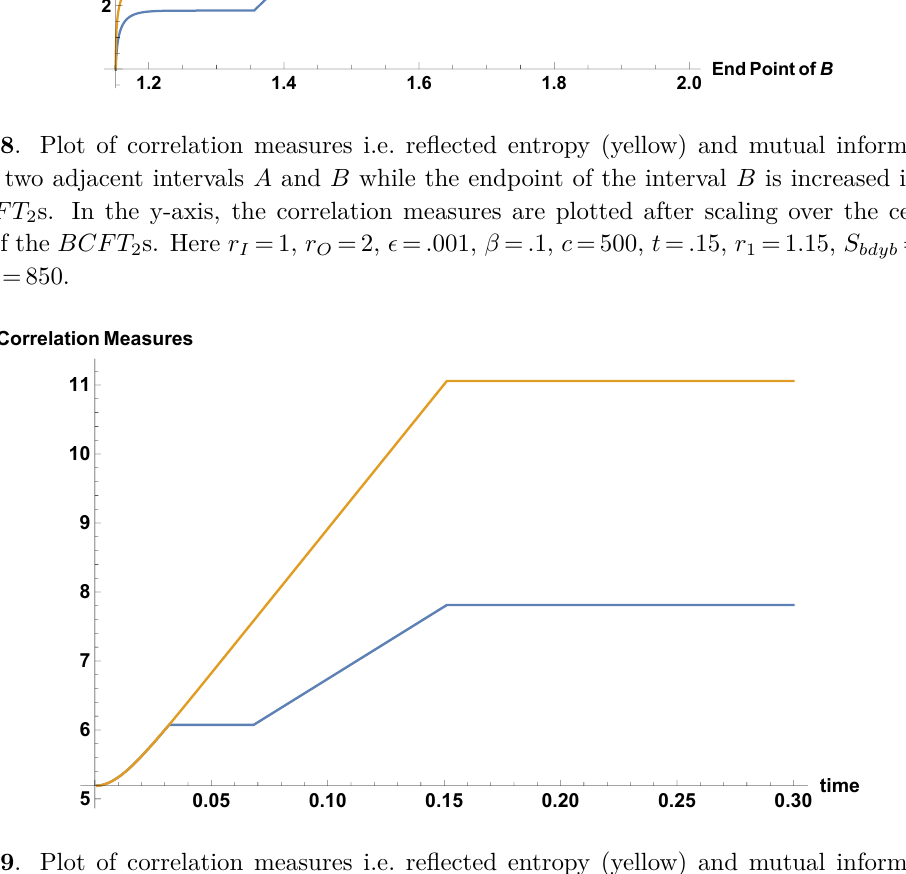
Figure 39 . Plot of correlation measures i.e. reflected entropy (yellow) and mutual information (blue) for two adjacent intervals A and B in the dual BCFT 2 s with increasing time. In the y-axis, the correlation measures are plotted after scaling over the central charge c of the BCFT 2 s. Here r I = 1 , r O = 2 , (cid:15) = . 001 , β = . 1 , c = 500 , S bdyb = 875 and S bdya = 850